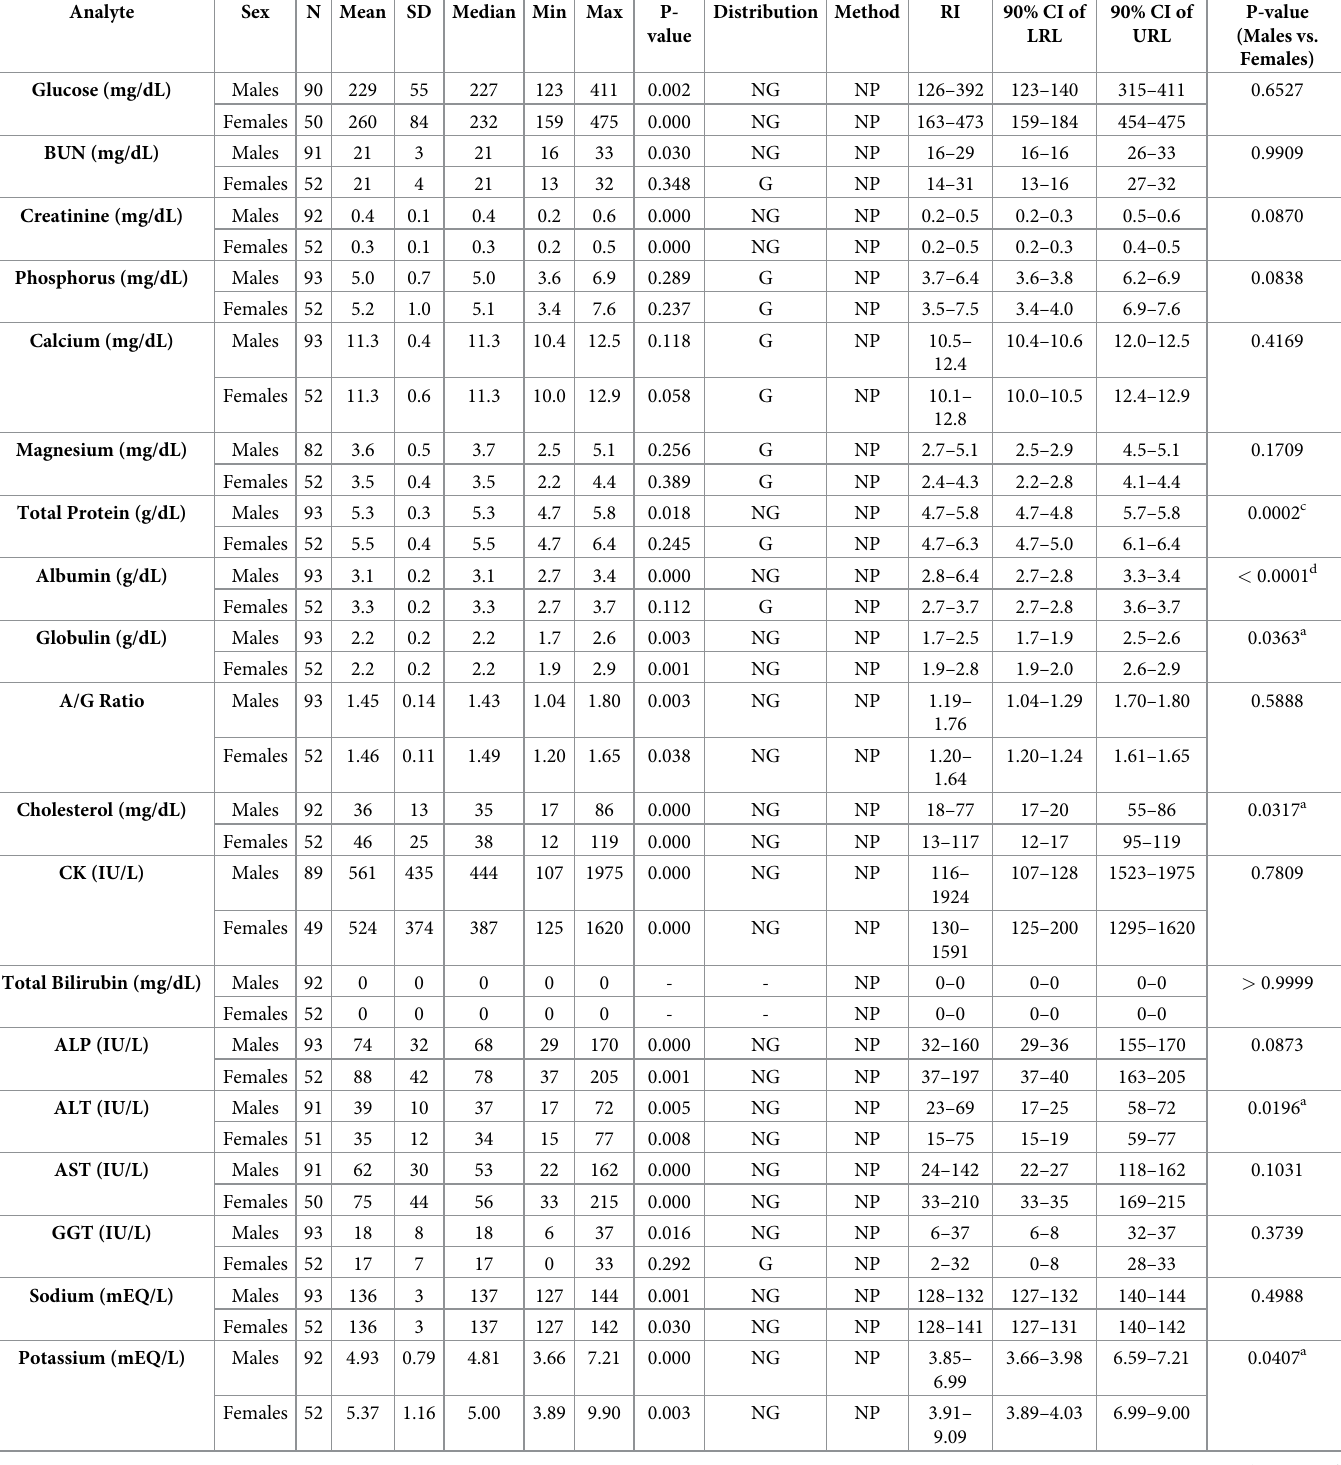
Table 6. Summary data and reference intervals for serum biochemistry parameters of adult male and female Hartley guinea